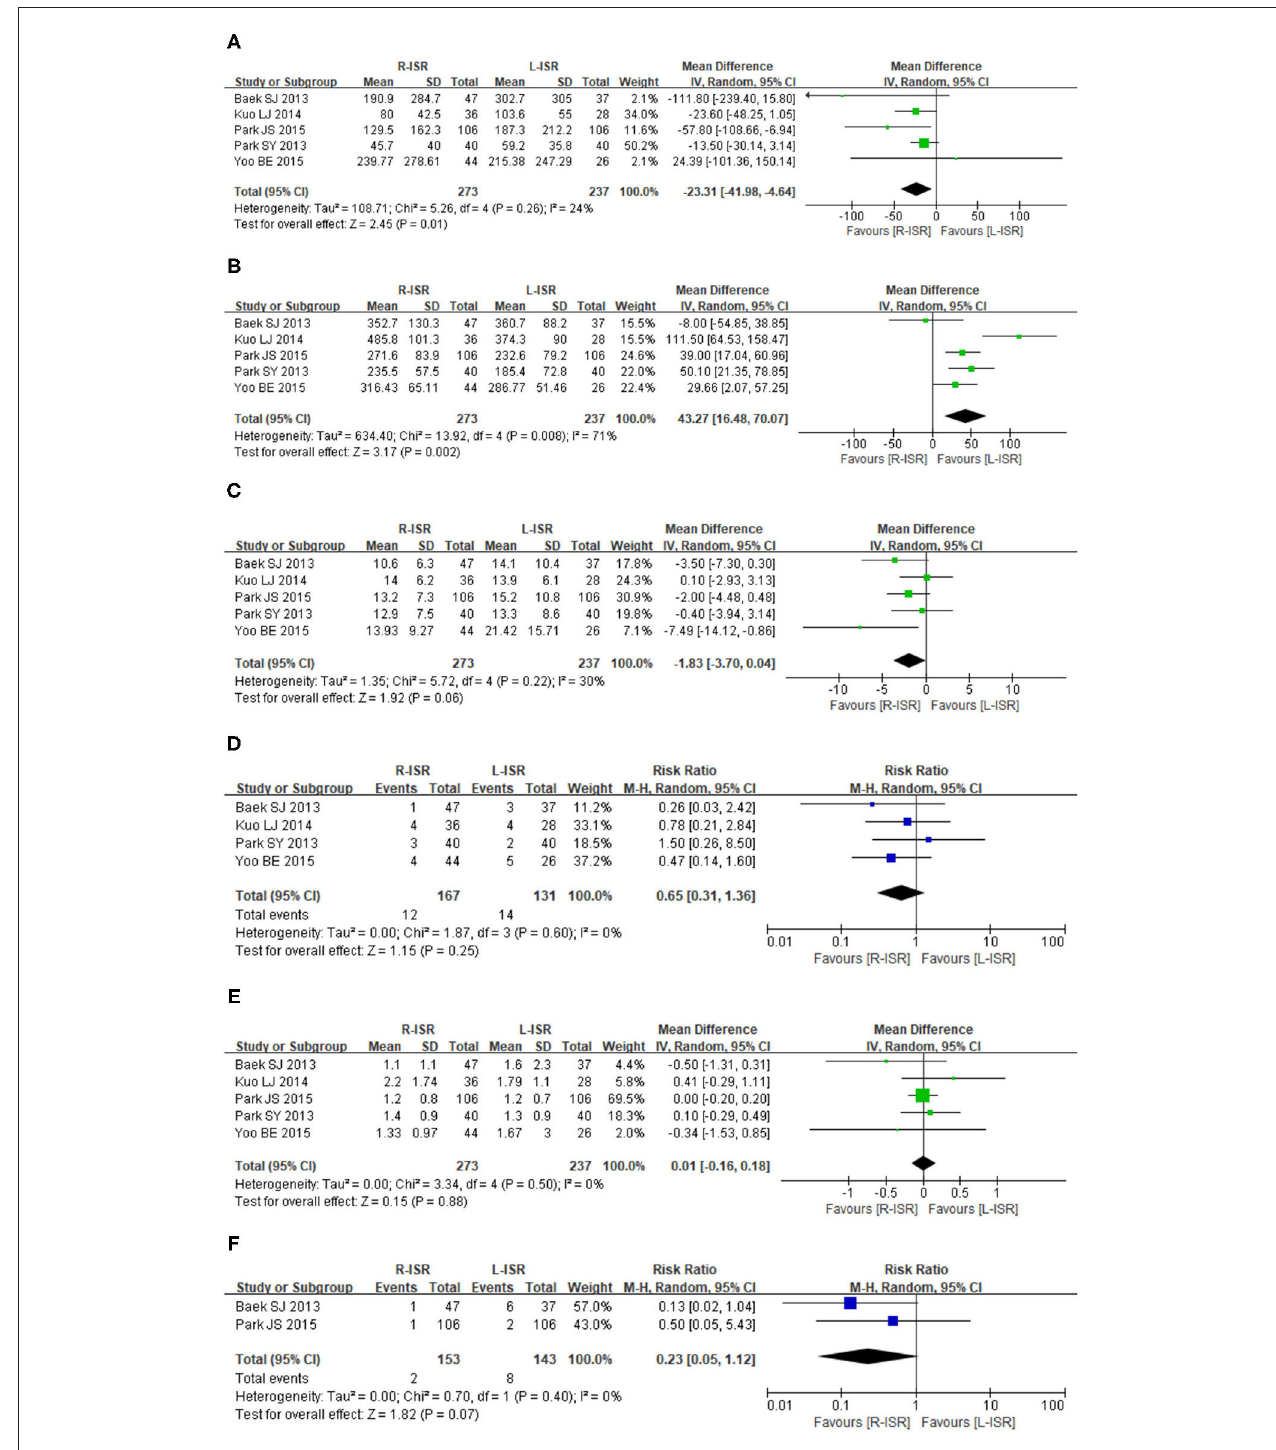
FIGURE 2 | Forest plots of perioperative outcomes comparing intraoperative blood loss (A) , operative time (B) , the number of retrieved lymph nodes (C) , circumferential resection margin (D) , distal resection margin (E) , and conversion rate (F) .